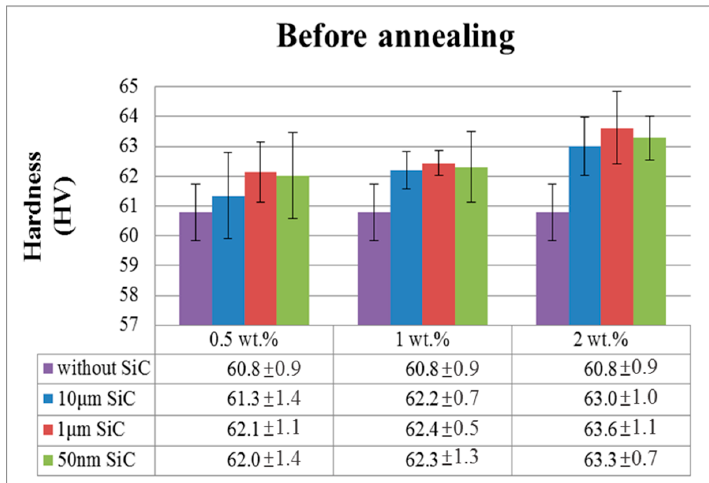
Figure 5. Hardness of the AZ61/SiCp MMC extruded plates before annealing.